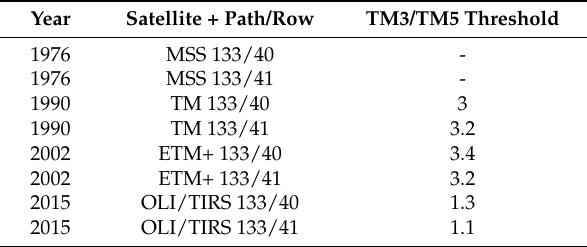
Table 2. Overview of applied thresholds for the TM3/TM5 band ratio images to identify the glacier